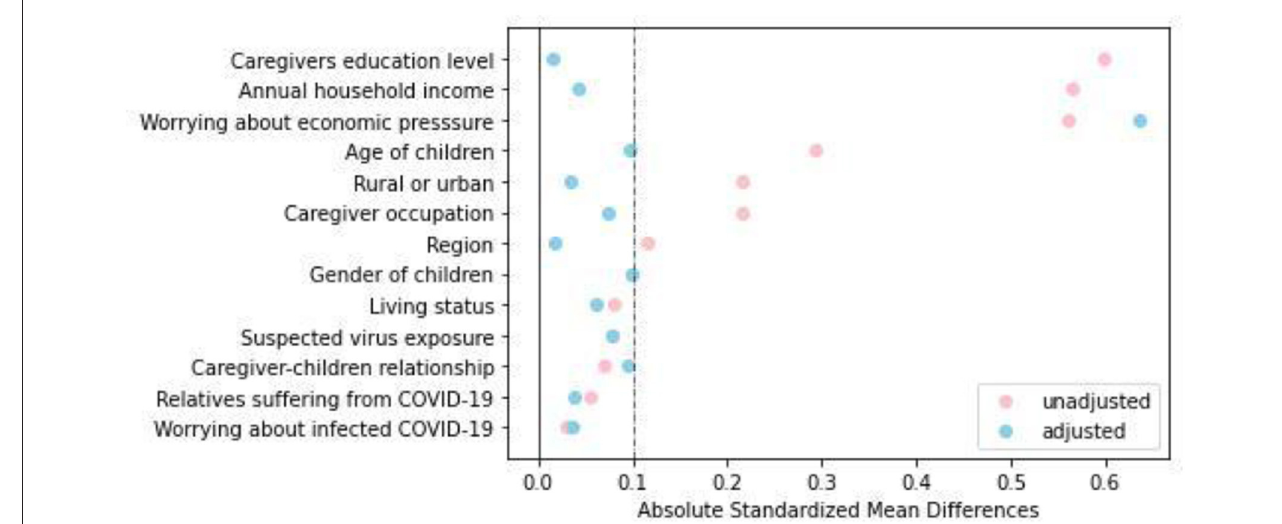
FIGURE 2 | Dot plot of absolute standardized mean differences (Cohen’s d) for all variables before and after